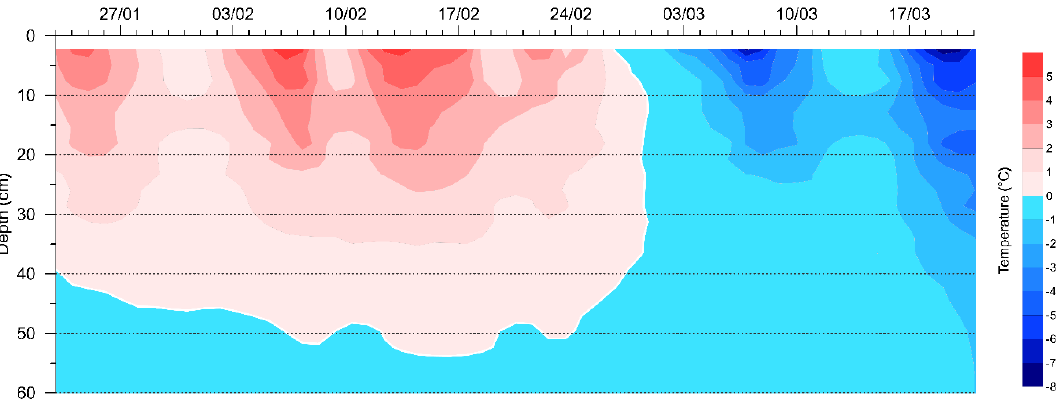
Figure 4. Ground temperature development at study site between 23 January and 21 March, 2018. Daily mean Q G was the highest on 11 March, when it reached 23.9 W m –2 . The Q G on 11 March led to warming of the whole column from the ground surface to a depth of about 30 cm (Figure 4), with daily mean ground surface temperatures rising by 5.3 °C between 10 and 11 March, while the increase was by 0.2 °C at a depth of 30 cm. On 1 February, 24 February and 11 March, the change in